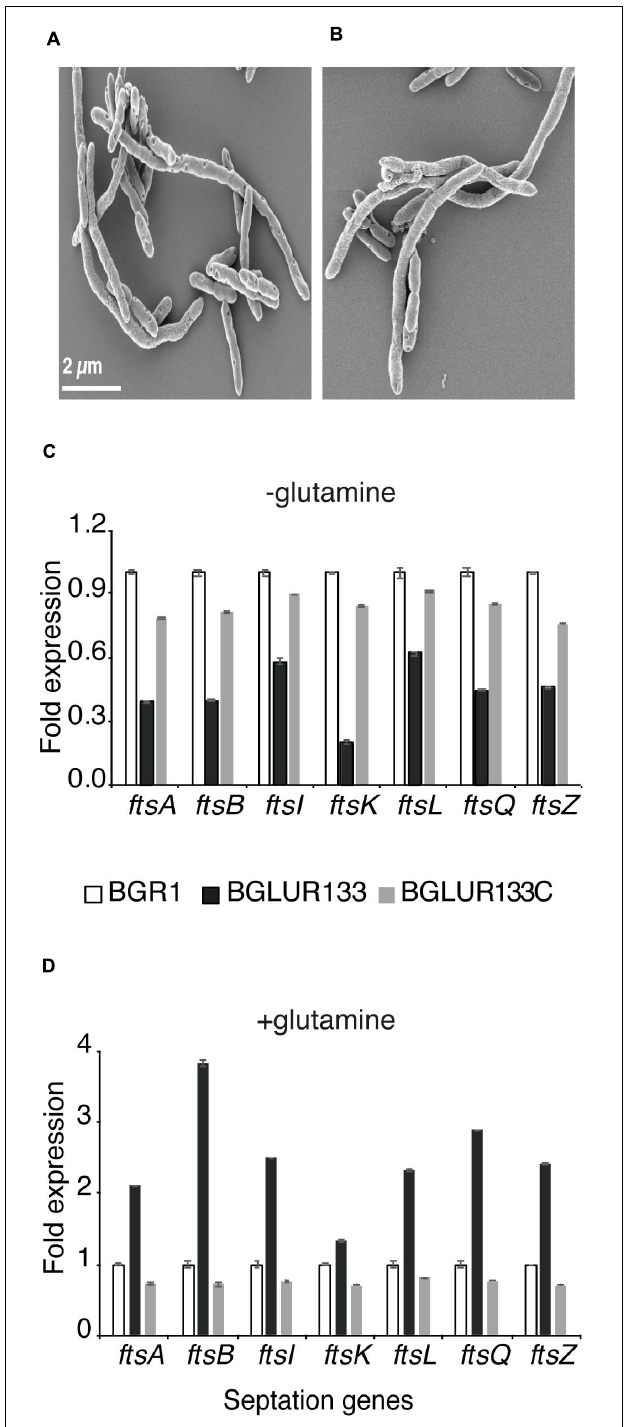
FIGURE 6 | Extracellular glutamine and glutamate are required for GluR-mediated cell division. The gluR mutant BGLUR133 formed filamentous cells in glutamine (A) and glutamate (B) -rich M9 minimal medium. (C,D) Differences in the expression levels of septation genes in plain M9 (C) and glutamine-rich M9 minimal medium (D) , analyzed by qRT-PCR using the wild-type BGR1 as the baseline. Data are means ± standard error (SE) of triplicates.